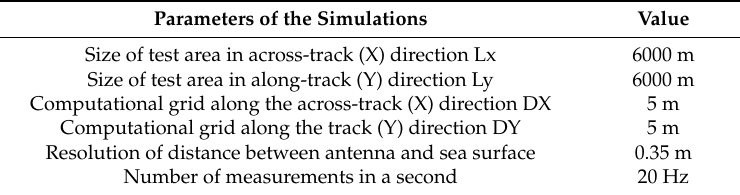
Table 3. Main parameters of the multi-look 20 Hz numerical simulations.